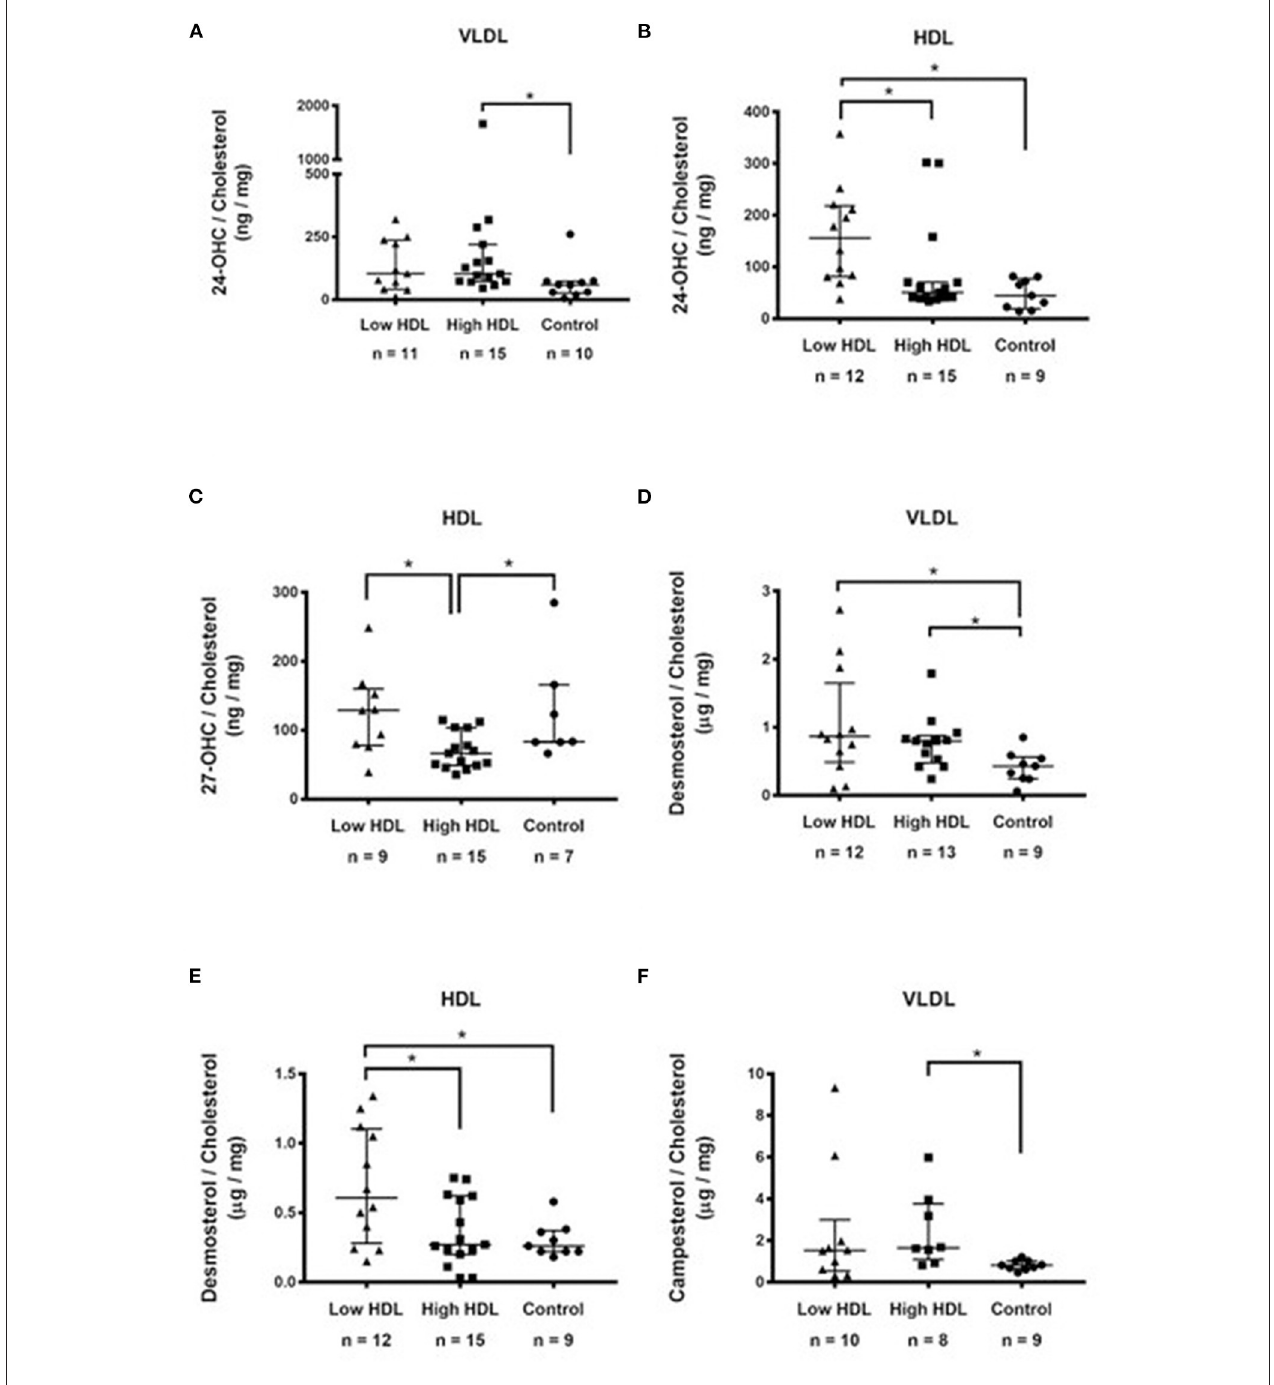
FIGURE 1 | Sterols in lipoproteins expressed as their ratios to cholesterol belonging to each lipoprotein fraction: (A) 24-hydroxycholesterol (ng/mg) in VLDL; (B) 24-hydroxycholesterol (ng/mg) in HDL; (C) 27-hydroxycholesterol (ng/mg) in HDL; (D) Desmosterol in VLDL ( µ g/mg); (E) Desmosterol ( µ g/mg) in HDL; (F) Campesterol ( µ g/mg) in VLDL. Results were compared between groups by Kruskal-Wallis followed by the post hoc Dunn’s test. * p < 0.05.